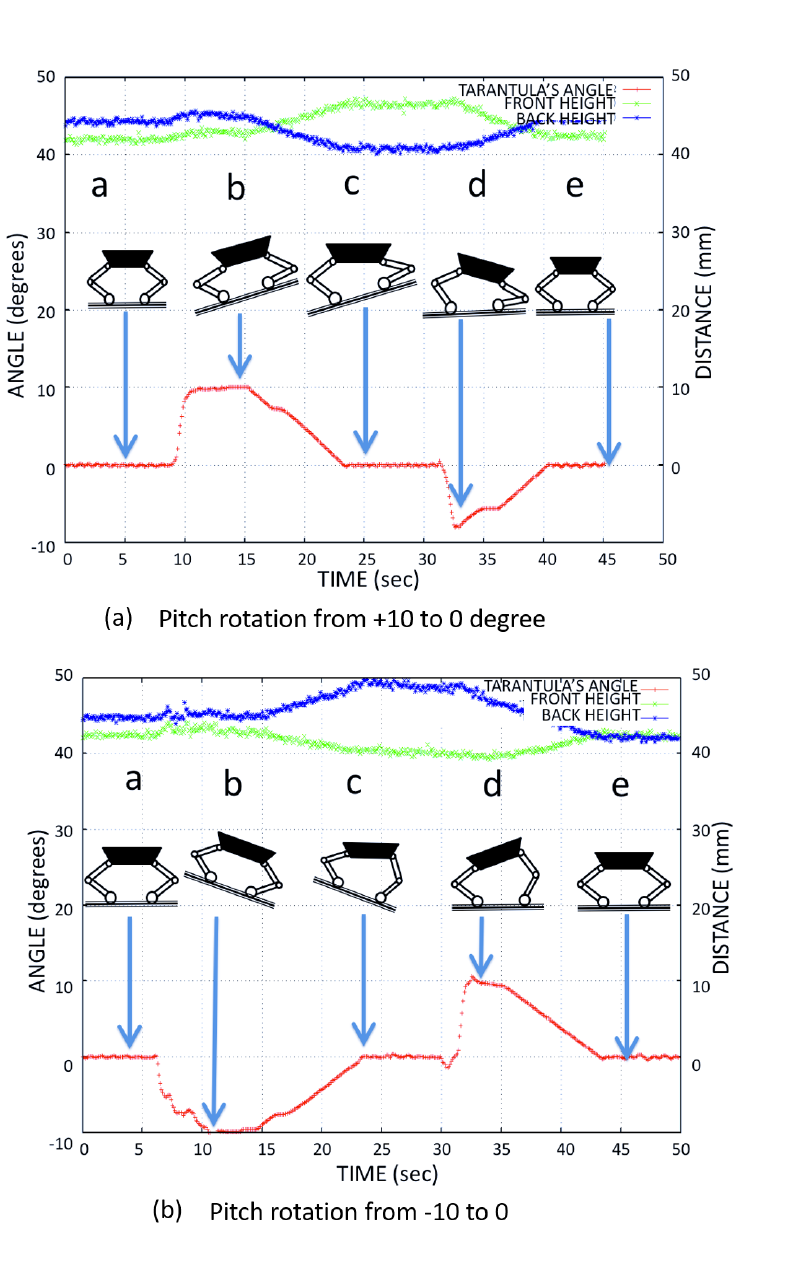
Figure 18. The Tarantula leg heights used for body balance during ( a ) 10 ◦ and ( b ) − 10 ◦ tilt angles of the